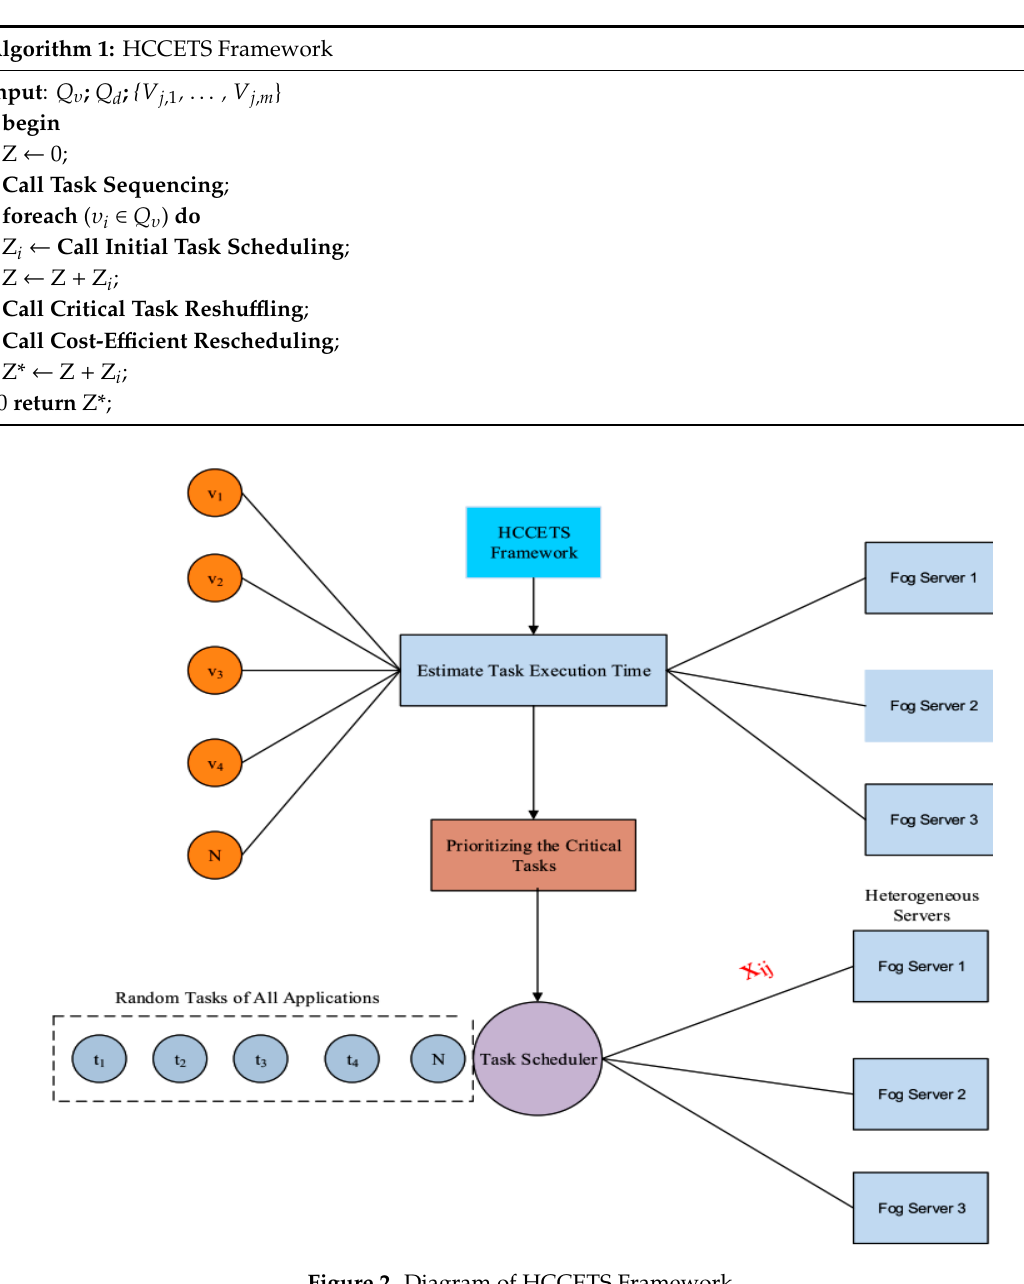
Figure 2. Diagram of HCCETS Framework.